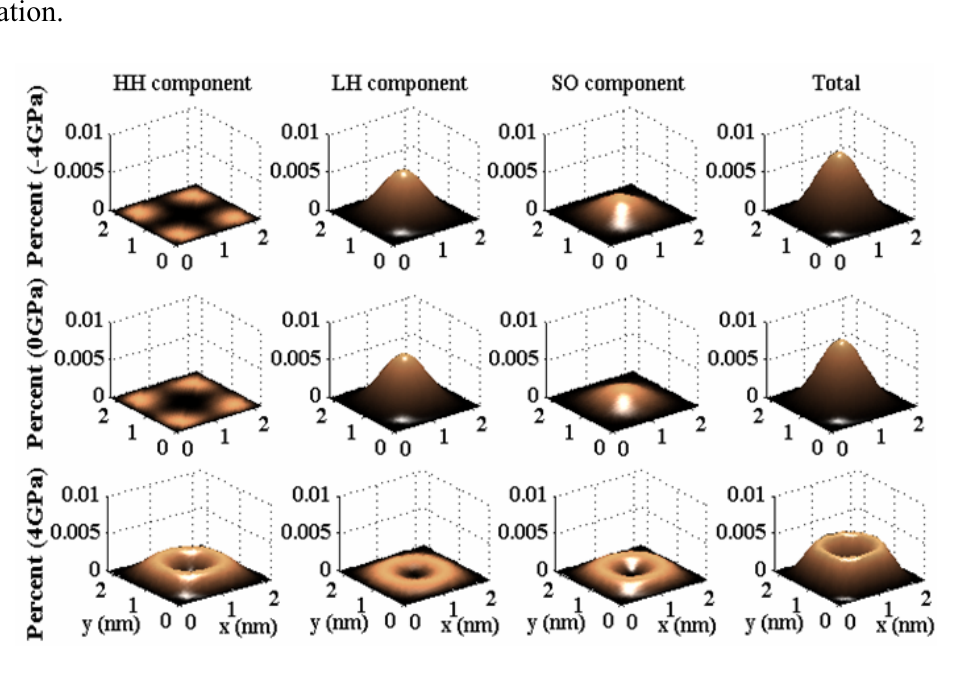
Figure 4. HH component, LH component, and SO component of the wave function of the ground state at 0  k in the simulated strained and unstrained SiNWs along [100] channel z